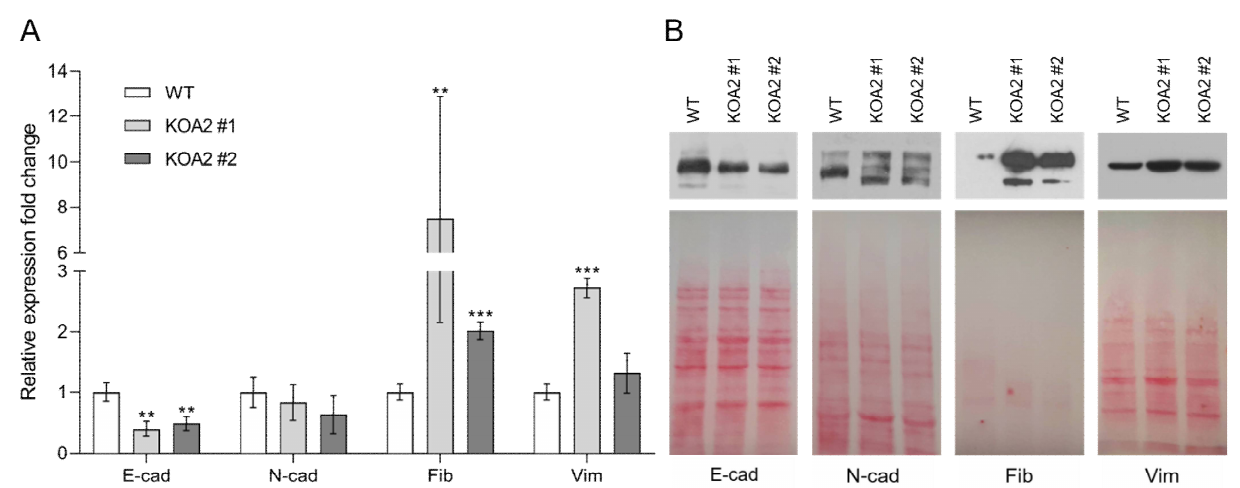
Figure 4. The effect of SLC35A2 deficiency on the transcript ( A ) and protein ( B ) levels of the selected EMT markers. ( A ) Quantitative analysis of the expression levels of the selected genes in wild-type and SLC35A2-deficient MDCK cells. The heights of the columns represent relative fold changes of the expression in the knockouts with respect to the wild-type. Error bars represent ±1 SD. Asterisks indicate statistically important differences between wild-type cells and individual clones. The significance level was set at p ≤ 0.01 (**) and p ≤ 0.001 (***). Data were analyzed using unpaired t -test. ( B ) Western blotting analysis of intracellular (E-cadherin, N-cadherin, vimentin) and extracellular (fibronectin) protein levels. Ponceau S stainings are presented alongside to demonstrate equal loading. Representative data out of several independent experiments are shown. Abbreviations: E-cad, E-cadherin; N-cad, N-cadherin; Fib, fibronectin; Vim, vimentin.